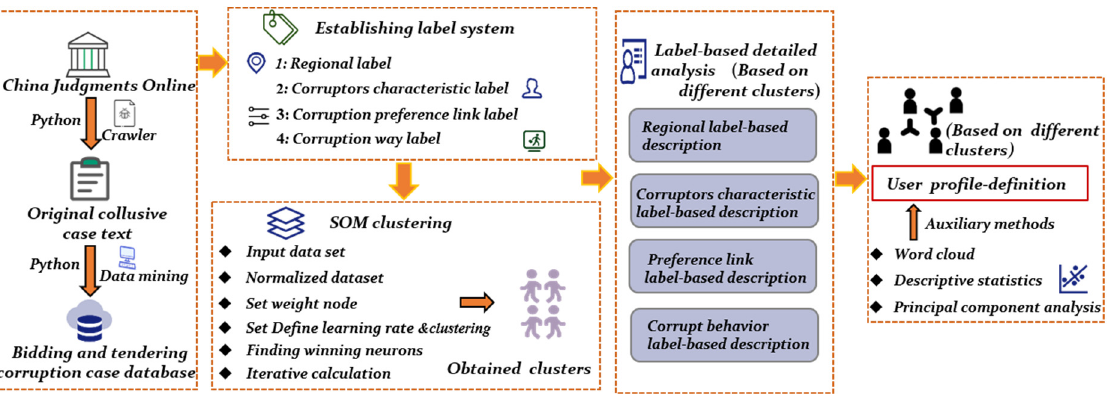
Figure 1. Flowchart of the study.